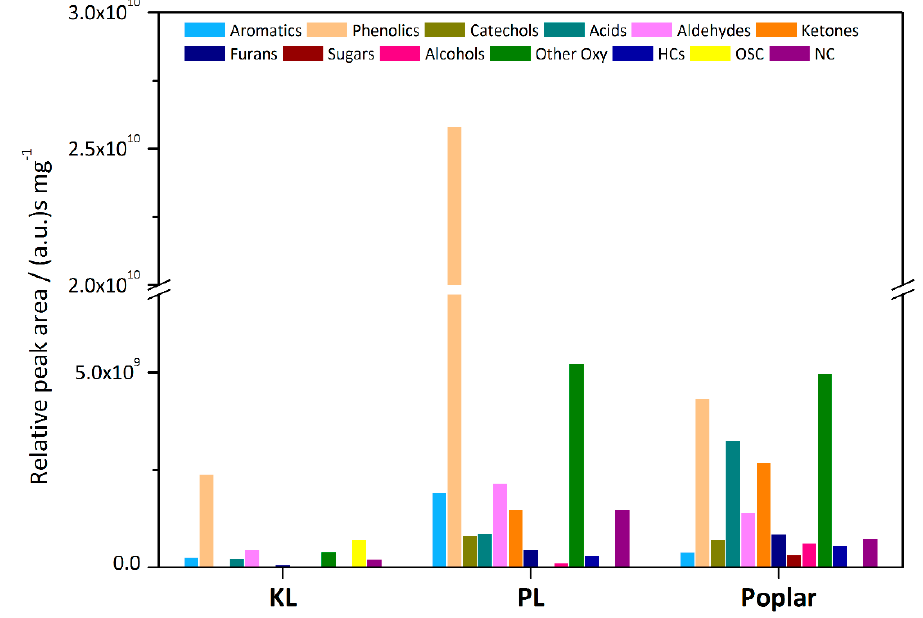
Figure 3. Pyrolysis product distribution of Kraft lignin (KL), pyrolytic lignin (PL) and poplar sawdust.